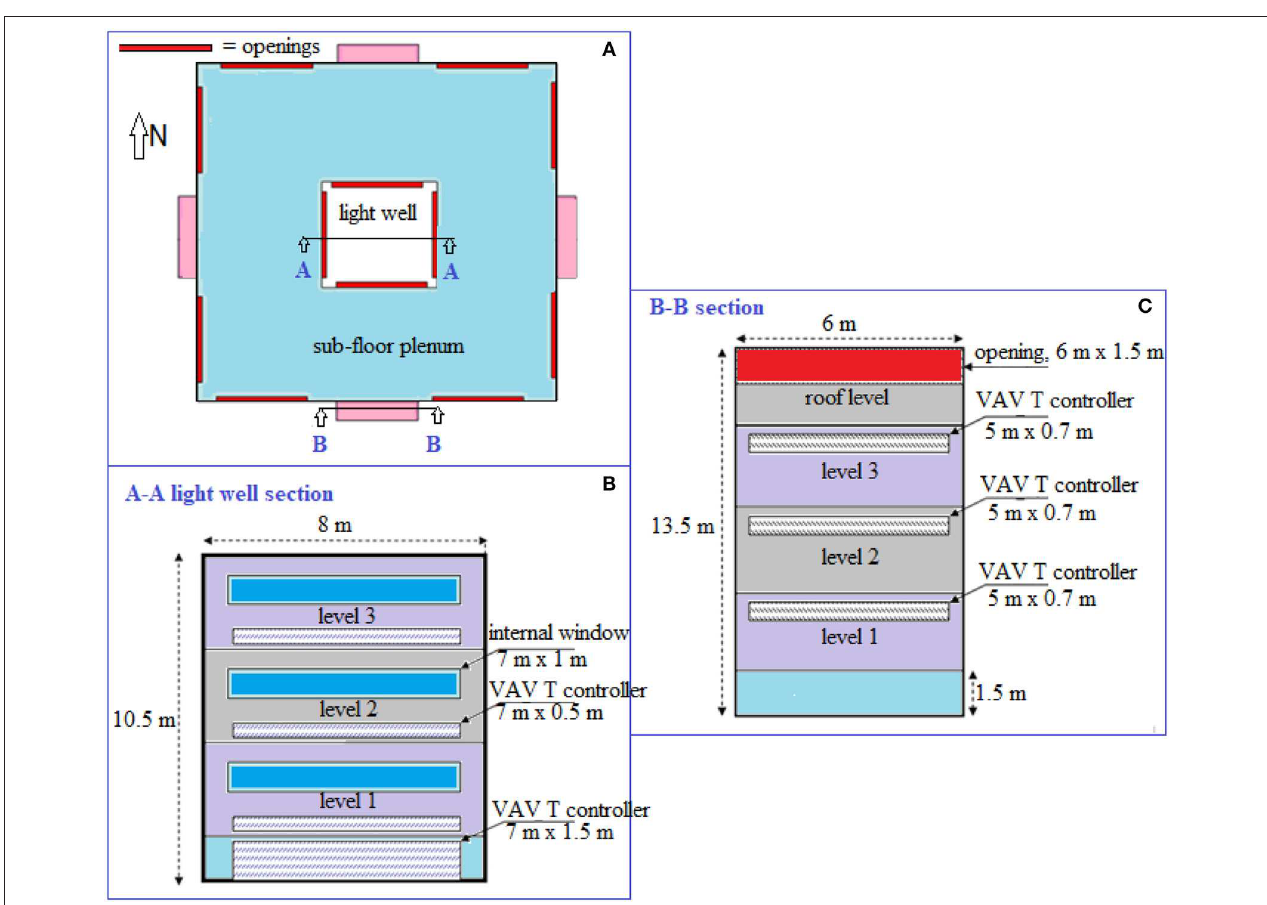
FIGURE 2 | 2-D views of the building: (A) Sub-floor Plenum—plan. (B) Light well section A-A: low level openings from light well to each story as well as Sub-floor Plenum openings. (C) Stack section B-B: High level outlets from each story to the exhaust